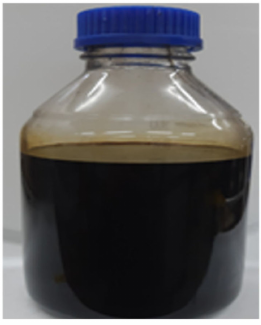
Figure 3. Crude waste tire pyrolysis oil